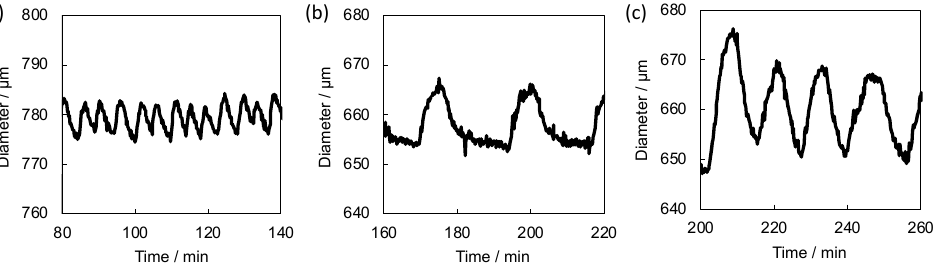
Figure 7. Time profiles of the hydrogel diameter of ( a ) SOG-10, ( b ) SOG-20 and ( c ) SOG-30 during BZ reaction at 20 °C. The catalyst-free BZ solution contains HNO 3 (894 mM), NaBrO 3 (100 mM) and malonic acid (64 mM) at 20 °C.